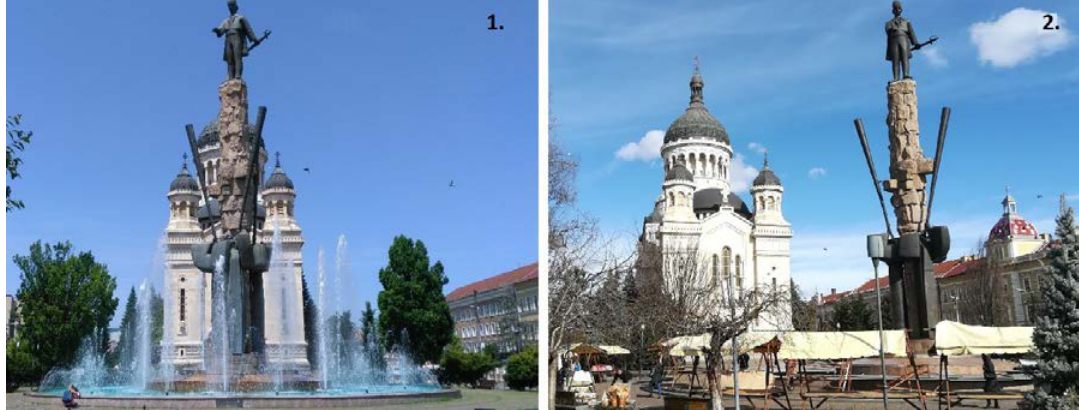
Figure 7: Avram Iancu Square - interior view from the south